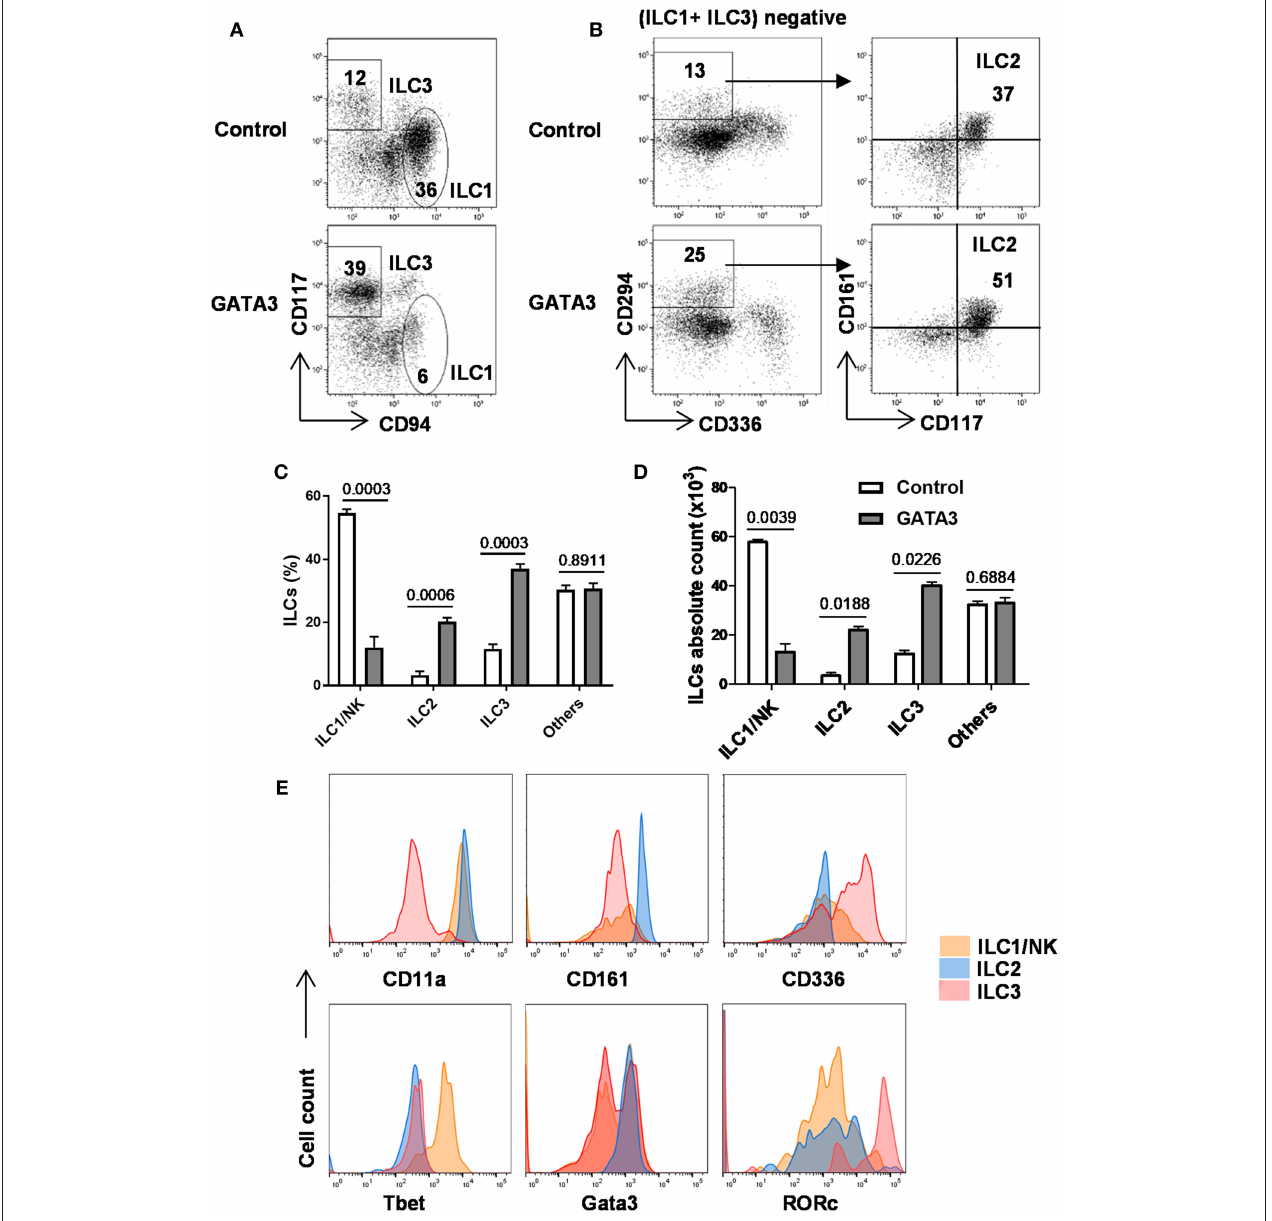
FIGURE 5 | GATA3 induces the generation of ILC2 and ILC3 at the expenses of ILC1/NK cells. Five-day expanded cord-blood derived CD34 + HSCs were transfected with either GATA3 mRNA (GATA3) or control mRNA (Control) and then differentiated under conditions that favor the development of ILCs (see methods). (A,B) Both control (upper row) and GATA3 (lower row) mRNA transfected CD34 + HSCs were stained for ILCs surface markers at day 28 of differentiation culture and CD94 + ILC1/NK and CD117 + ILC3 (A) , and CD294 + ILC2 (B) from a representative donor are shown in dot plots ( n = 6). Values represent the percentages of ILCs in the culture. (C,D) Differentiating CD34 + HSCs were stained for ILCs surface markers at day 28 of culture and the percentage (C) or absolute number (D) of CD94 + ILC1/NK, CD294 + ILC2, and CD117 + ILC3 are shown in bar graphs ( n = 6/group). (E) Differentiating CD34 + HSCs were stained for surface CD11a, CD161, CD336, and intracellular Tbet, Gata3, ROR γ t at day 28 of culture and the representative histograms are shown ( n = 6/group). (C,D) Data are shown as means ± SD, p -values are depicted and paired two-tailed t-tests.